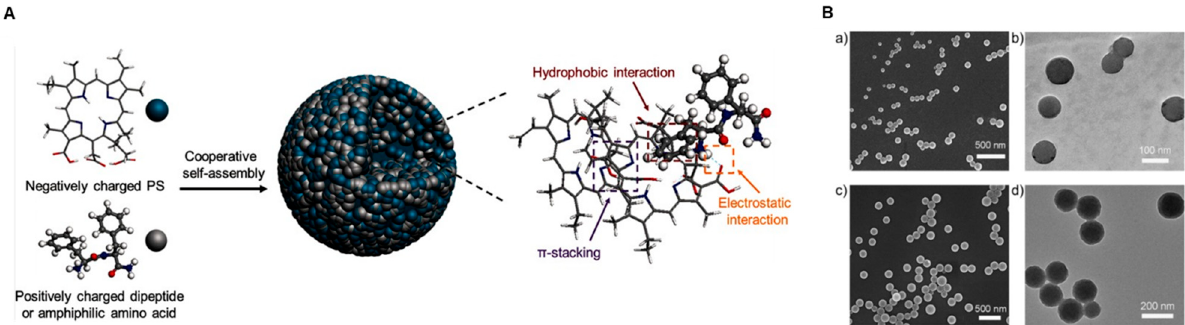
Figure 2. ( A ) A scheme for fabrication of photosensitive nanoparticles by amphiphilic dipeptide- or amino acid-tuned self-assembly. ( B ) ( a ) Scanning electron microscopy (SEM) image and ( b ) transmission electron microscopy (TEM) image of assembled Fmoc- L -Lys/Ce6 nanoparticles using Fmoc- L -Lys (2.0 mg mL − 1 ) and chlorin e6 (Ce6) (0.5 mg mL − 1 ) as building blocks. ( c ) SEM image and ( d ) TEM image of assembled cationic diphenylalanine (CDP)/Ce6 nanoparticles using CDP (2.0 mgmL − 1 ) and Ce6 (0.5 mgmL − 1 ) as building blocks (reproduced with permission from